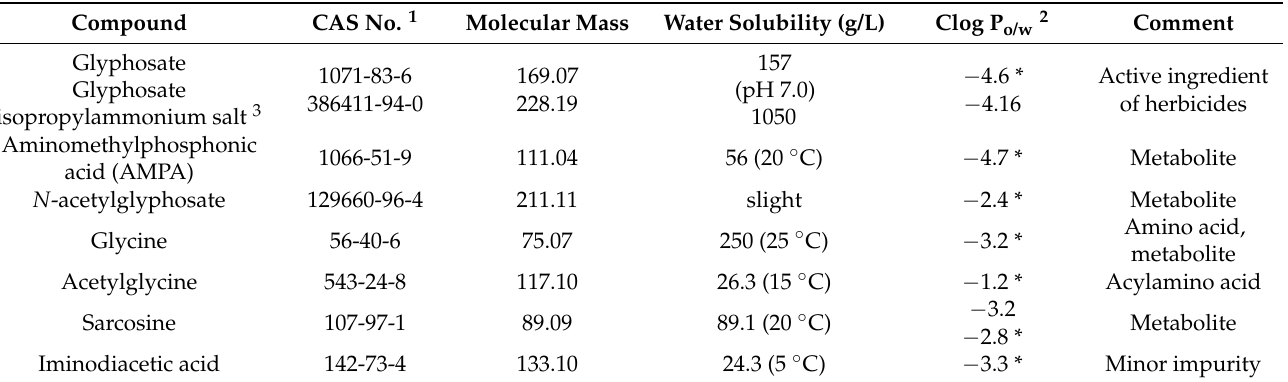
Table 1. Physicochemical properties of the ligands studied.